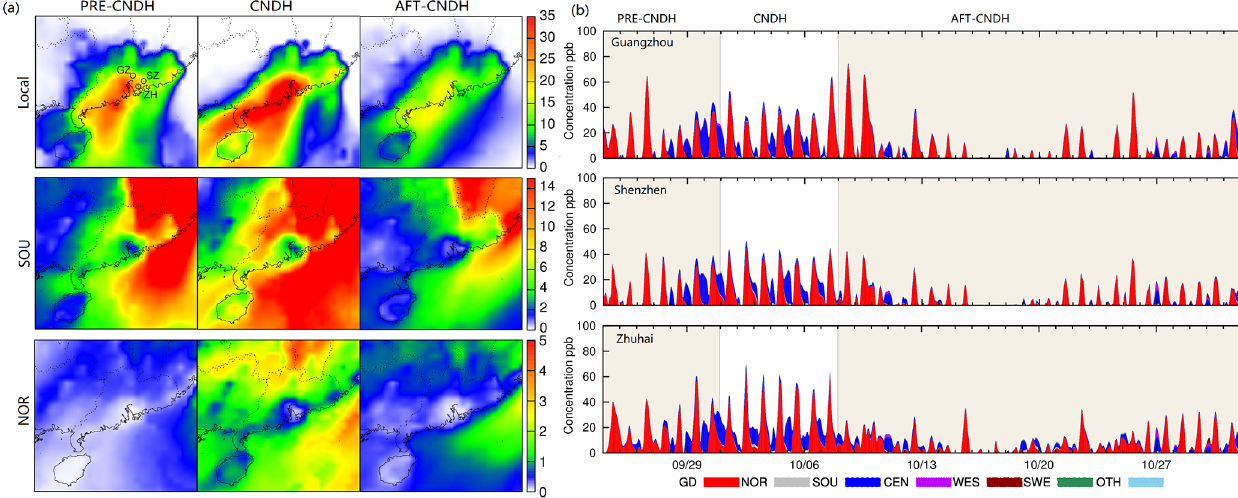
Figure 5. (a) Average regional contributions to non-background O 3 from the PRD local emissions and emissions in SOU and NOR sectors and (b) regional contributions from all sectors to non-background O 3 in the key PRD cities (Guangzhou, Shenzhen, and Zhuhai) during the simulation periods. GZ: Guangzhou, SZ: Shenzhen, and ZH: Zhuhai.